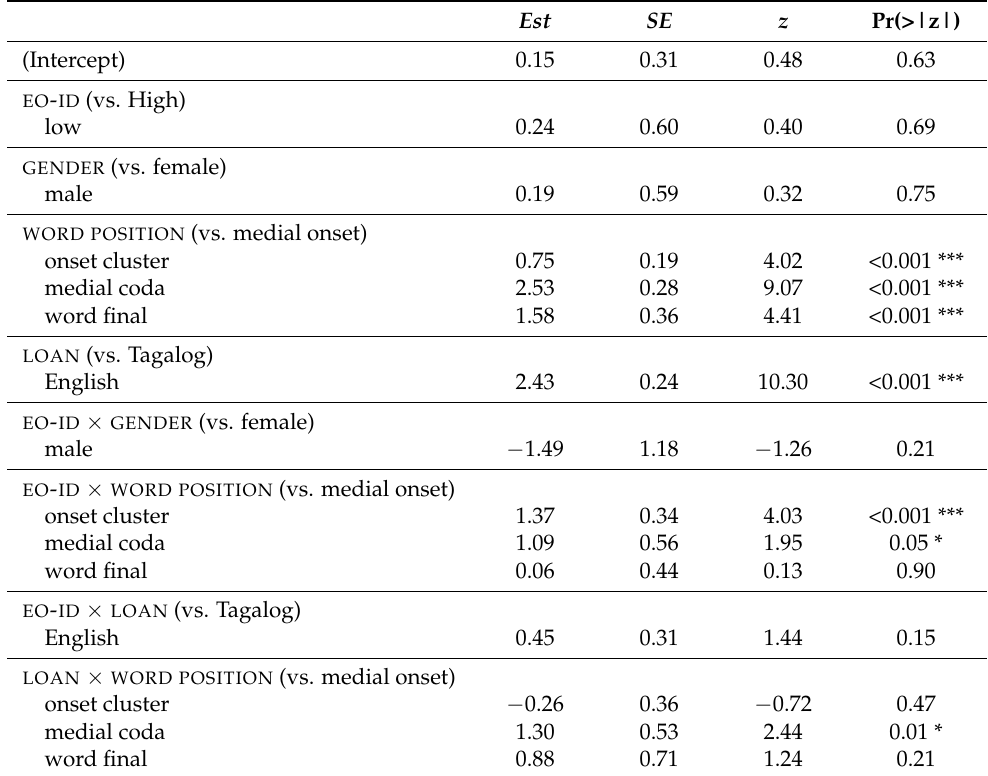
Table 10. Mixed-effects model for heritage speakers (n = 1852), comparing speakers with high EO versus low EO scores for ethnic identity. Positive estimate values indicate a favoring environment for the approximant. Significance codes: <0.001 ‘***’; <0.05 ‘*’. Est SE z Pr(>|z|)